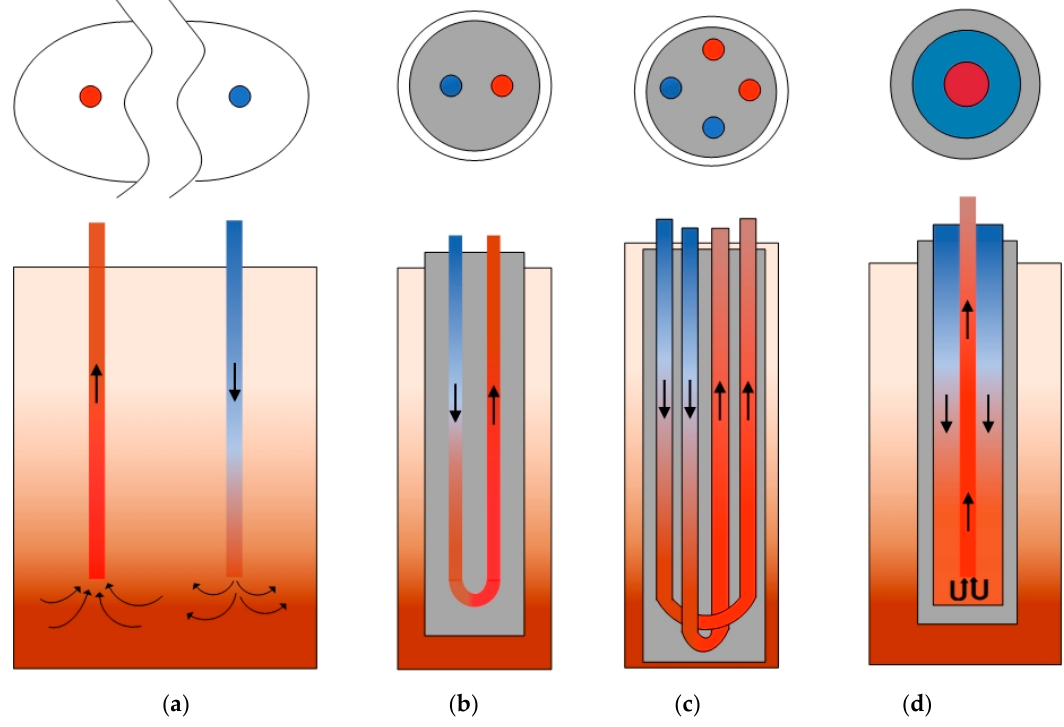
Figure 3. Extraction technologies: ( a ) producer-injector doublet, ( b ) borehole heat exchanger single U-tube, ( c ) borehole heat exchanger double U-tube, ( d ) coaxial borehole heat exchanger.